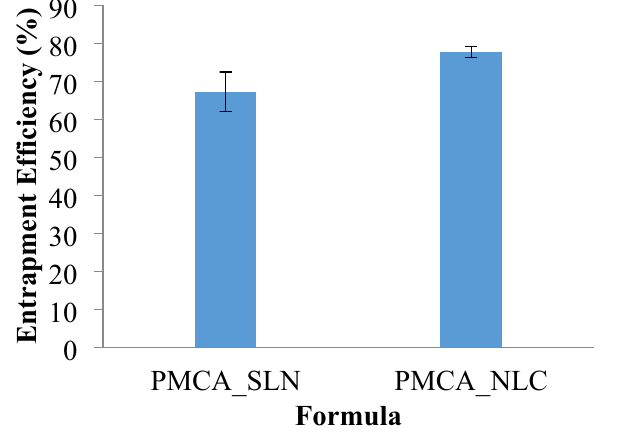
Figure 1. Entrapment efficiency of PMCA_SLN and PMCA_NLC.